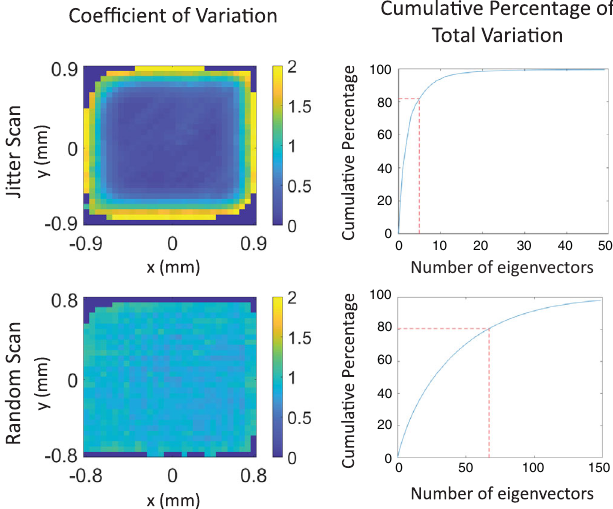
FIG. 2. Drive laser variation analysis for UCLA jitter scans (top row) and random scans (bottom row). The left-column shows the CV for each pixel. Note that edge pixels that have a mean of approximately zero have been discarded to avoid division by zero errors. The right-column shows the cumulative percentage of total variation contained within the eigenvectors of the dataset. The dashed lines indicates the number of eigenvectors containing 80% of the total variation. This was 5 eigenvectors for the jitter scans and 67 eigenvectors for the random scans. The total number of eigenvectors for both datasets was 900.